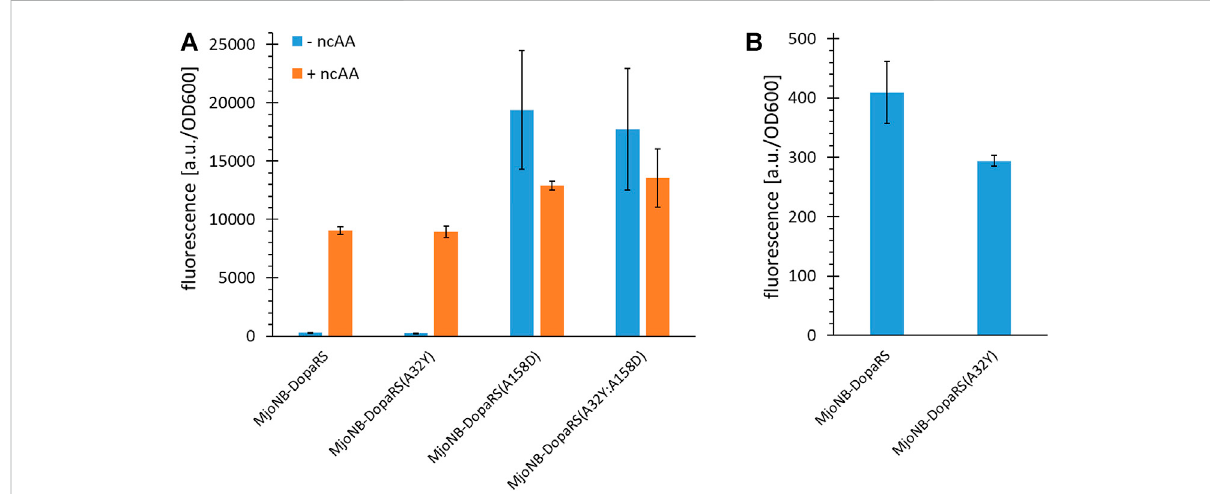
FIGURE 2 Ribosomalincorporationef fi ciencyof m - o NB-DopauponmutationofthencAAbindingpocketof Mj TyrRS. (A) OTSef fi ciency,seemaintextfor a detailed description of the reporter constructs. Ribosomal incorporation with ncAA (+ ncAA = 1 mM m - o NB-Dopa) and corresponding controls withoutncAAsupplementation. (B) Zoomedinpartof( A )tovisualizedifferencesinbackgroundstopcodonsuppressionofthe fi rsttwosetups.Intact cell fl uorescence of E. coli strain BL21(DE3) with SUMO-sfGFP(R2amber) as reporter protein, endpoint measurements after 18 h of incubation. Fluorescence values were normalized with corresponding OD 600 values to correct for differences in cell density. Data (incl. Standard deviation) represent the mean of three biological replicates.